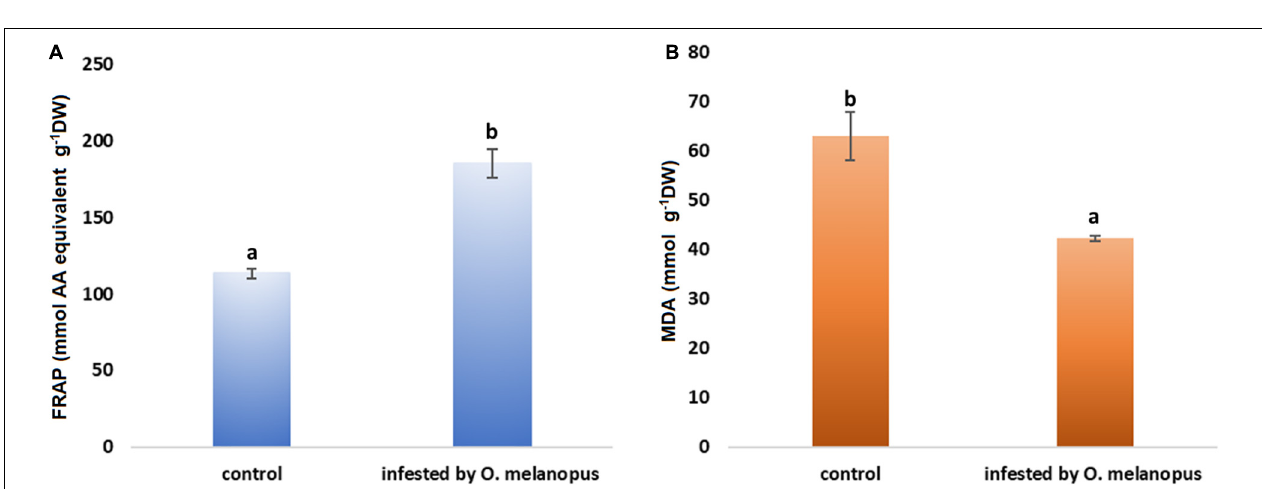
FIGURE 3 | Effect of O. melanopus infestation on (A) antioxidant capacity ( n = 15) (mmol AA equivalent g - 1 DW) and (B) lipid oxidation ( n = 30) (m g - 1 DW MDA equivalent) in wheat leaves. Mean values and standard deviations are presented. Different letters represent significant differences within the